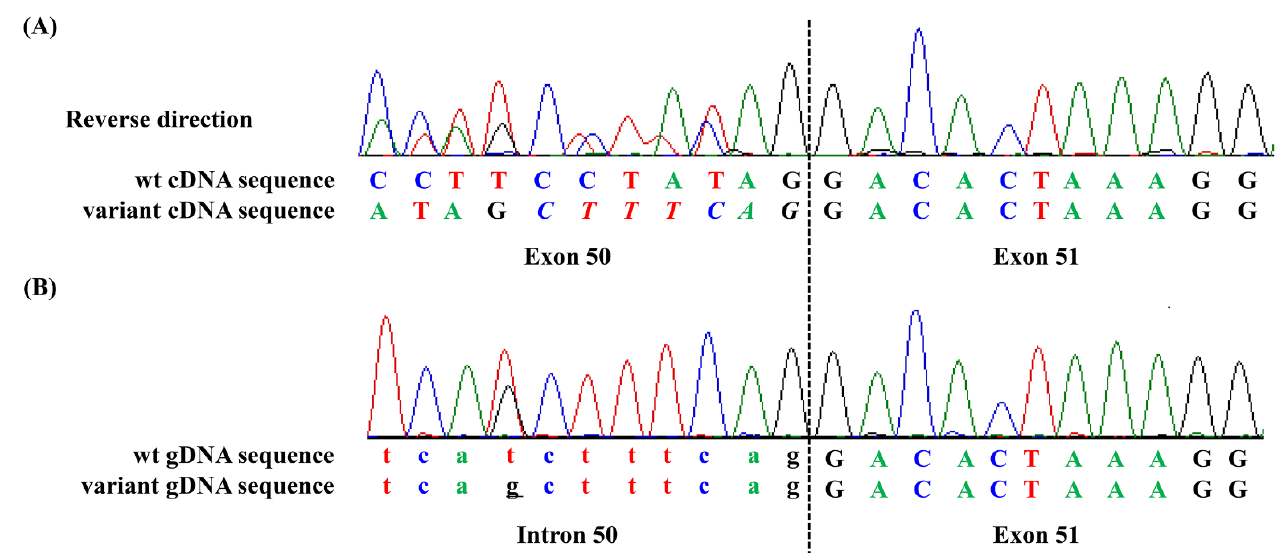
Figure 1. Electrophoretogram of the ( A ) complementary DNA (cDNA) and ( B ) genomic DNA (gDNA) from novel splice variant c.7458-8T>G, resulting in creation of a new 3′ splice site that leads to a 7-nt insertion of c.7458-7_7458-1. Below, cDNA and gDNA sequences of wild type (wt) and splice variant are presented. In the cDNA sequences, the inserted nucleotides are italicized. In the gDNA sequences, the nucleotide substitution is underlined. Small letters indicate the intronic sequence.